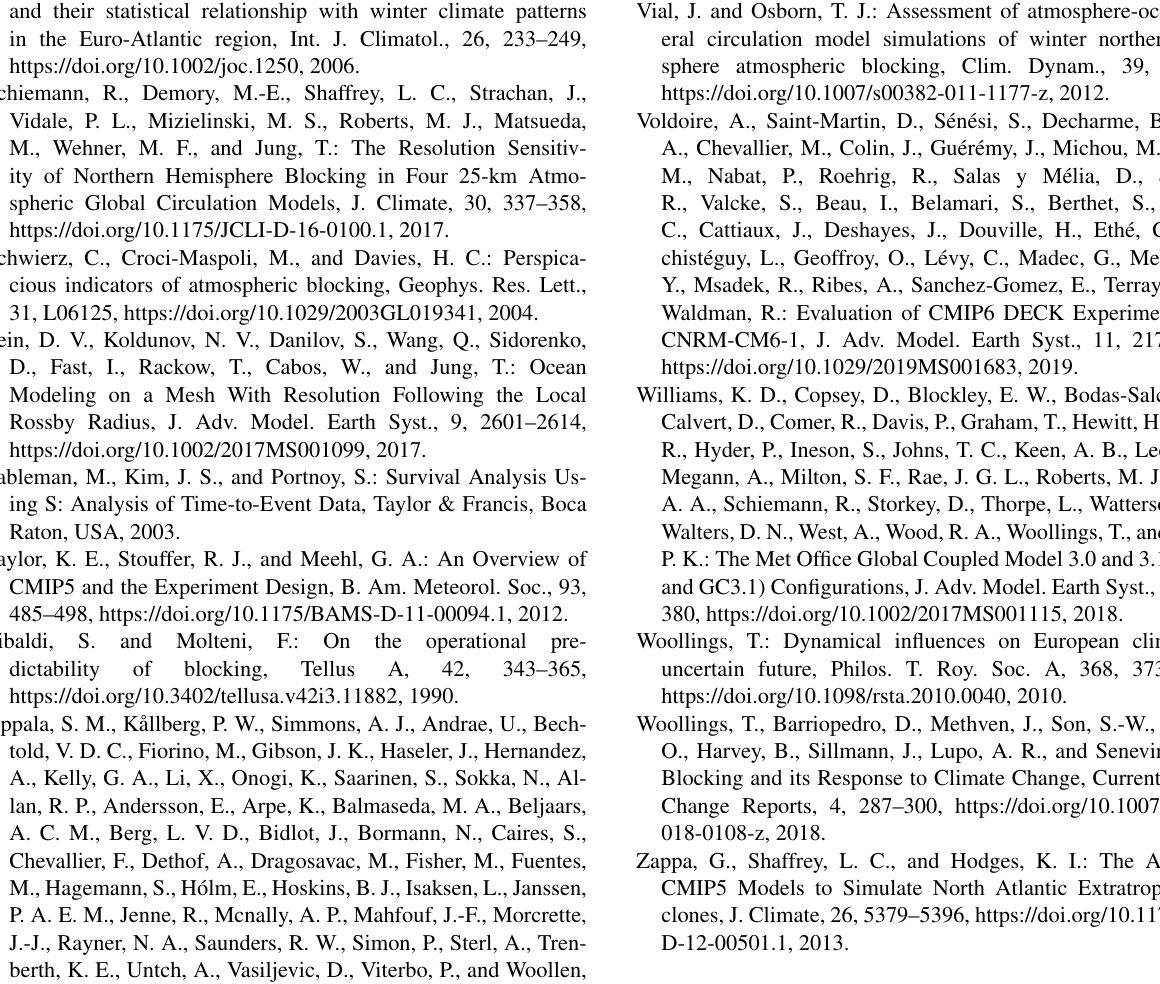
Tableman, M., Kim, J. S., and Portnoy, S.: Survival Analysis Us- ing S: Analysis of Time-to-Event Data, Taylor & Francis, Boca Raton, USA,